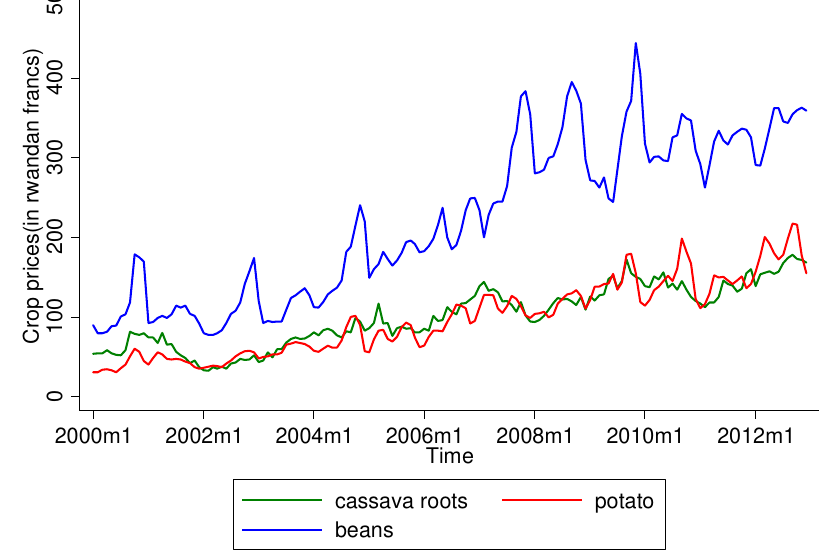
Fig. 1. Monthly average nominal price of the staple crops cassava roots, beans and potatoes in Rwanda, 2000  2015 Source: authors’ calculations based on data from the National Institute of Statistics of Rwanda (NISR)